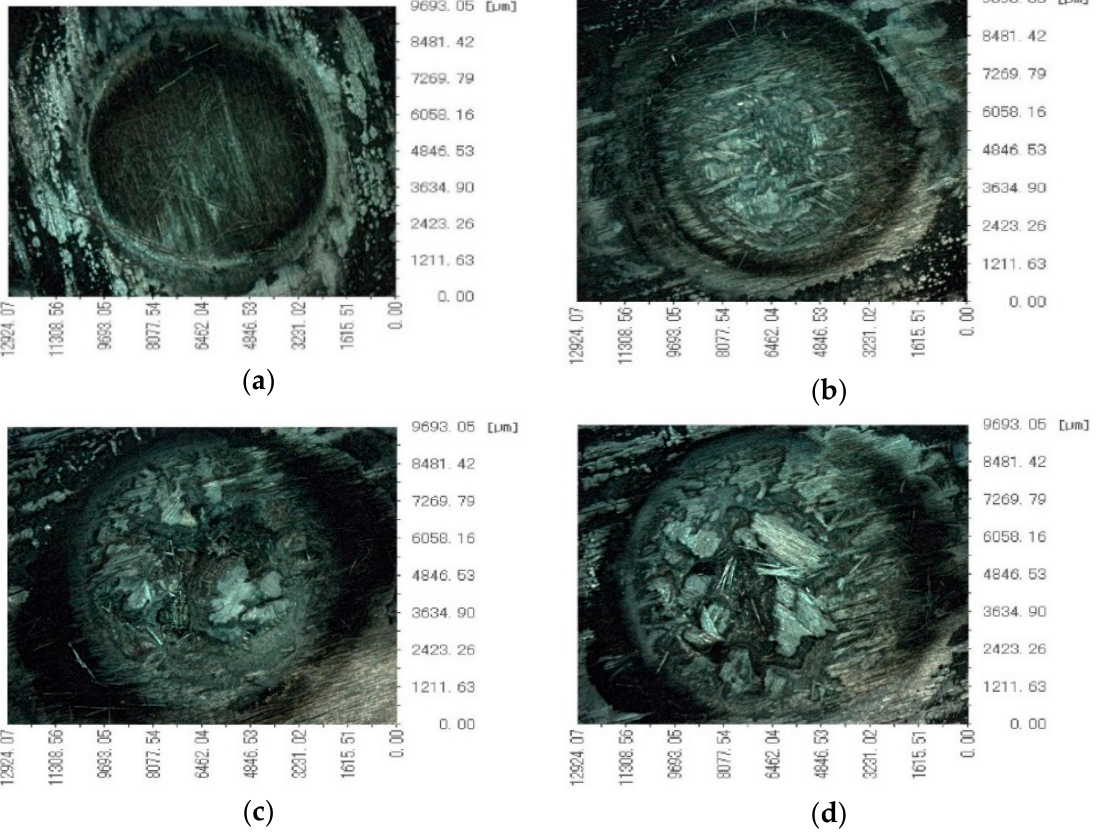
Figure 6. Ablation morphologies of CFRP laminates under VHX-100 digital microscope. ( a ) 250 W; ( b ) 500 W; ( c ) 750 W; ( d ) 1000 W. Table 2. The CFRP laminate ablation data in the atmospheric environment.